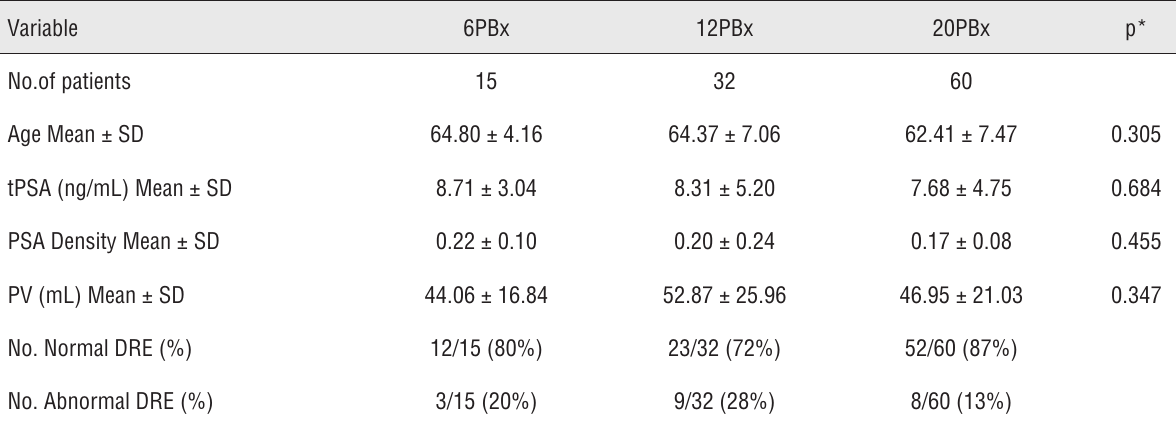
Table 1 - Patient